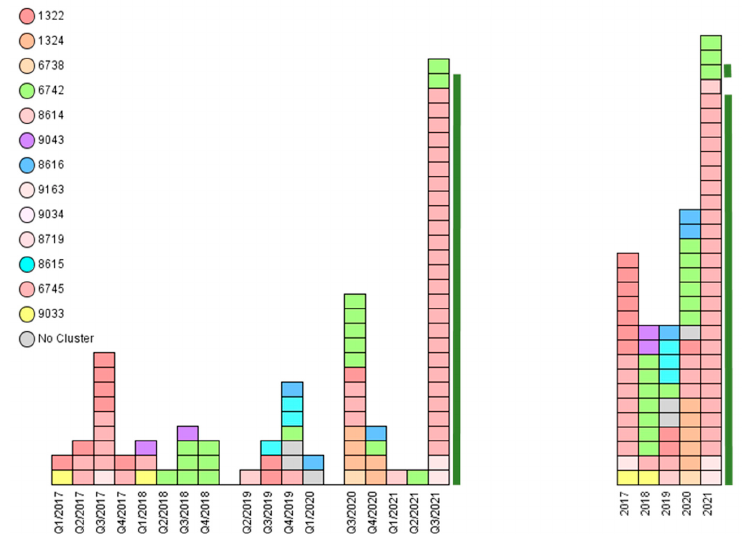
Figure 3. The epidemiological analysis of Salmonella Dublin animal disease outbreaks in Southern Bavaria revealed assorted genotypes within the 5-year investigation period. Each rectangle represents one isolate. Left: Complex types (CTs) distributed over the quarters (Q1 to Q4) of the years 2017 to 2021. Right: CTs distributed over the years 2017–2021. Most CTs persist over the years. Cluster 1 prevailed in 2017 and 2021. The 28 isolates from a 2021 outbreak on a mountain pasture in Garmisch-Partenkirchen are depicted with a green bar.